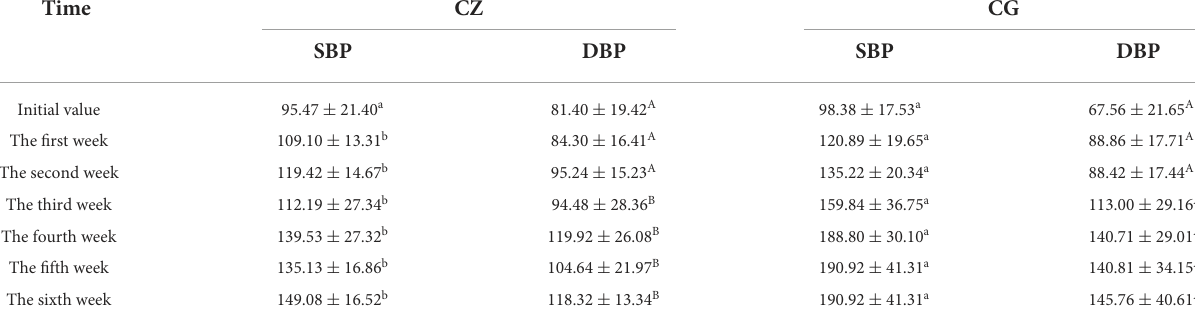
TABLE 1 Blood pressure of Wistar rats with a high salt diet